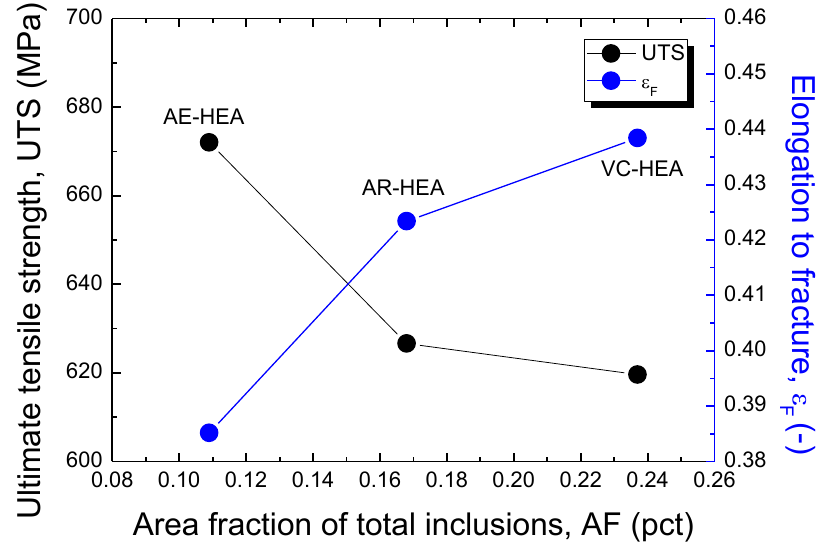
Figure 11. Comparison of ultimate tensile strength (UTS) and elongation to fracture ( ε f ) of HEAs according to the area fraction of total inclusions.